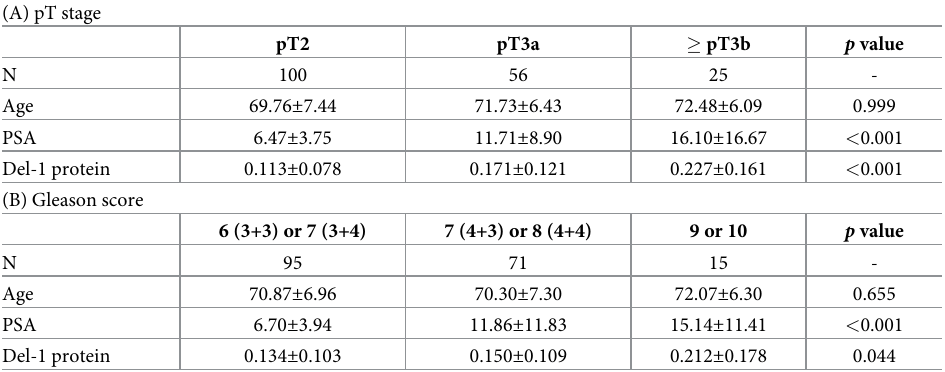
Table 4. Developmental endothelial locus-1 protein according to (A) pT stage and (B) Gleason score in 181 patients who underwent radical